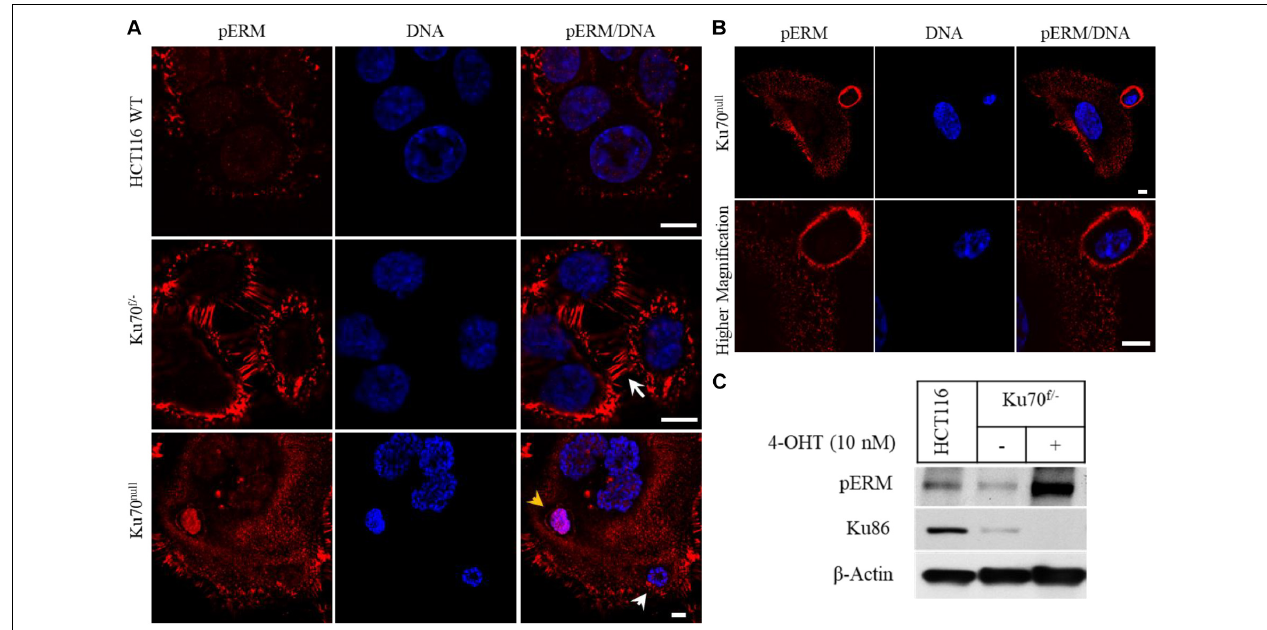
FIGURE 2 | Conditional loss of Ku70 in HCT116 cells leads to accumulation of phospho-ERM at cell membranes. HCT116 WT and Ku70 f / - cells were either left untreated or treated with 10 nM 4-OHT for 10 days. Cells were immuno-stained with a phospho-ERM antibody, and DNA labeled with DAPI. White arrow indicates elongated membrane protrusions, and arrow heads indicate engulfed nuclei/cell. The intact plasma membrane of an engulfed cell stained with the phospho-ERM (pERM) antibody is also shown (yellow arrow head). Scale bar, 10 µ m (A) . A typical “attacking cell” and “host cell” are shown in lower and higher magnification. Scale bar, 10 µ m (B) . HCT116 WT and Ku70 f / - cells were treated as described in (A) , and cell extracts were subjected to Western blot for detection of pERM proteins and Ku86. β -Actin served as loading control (C)